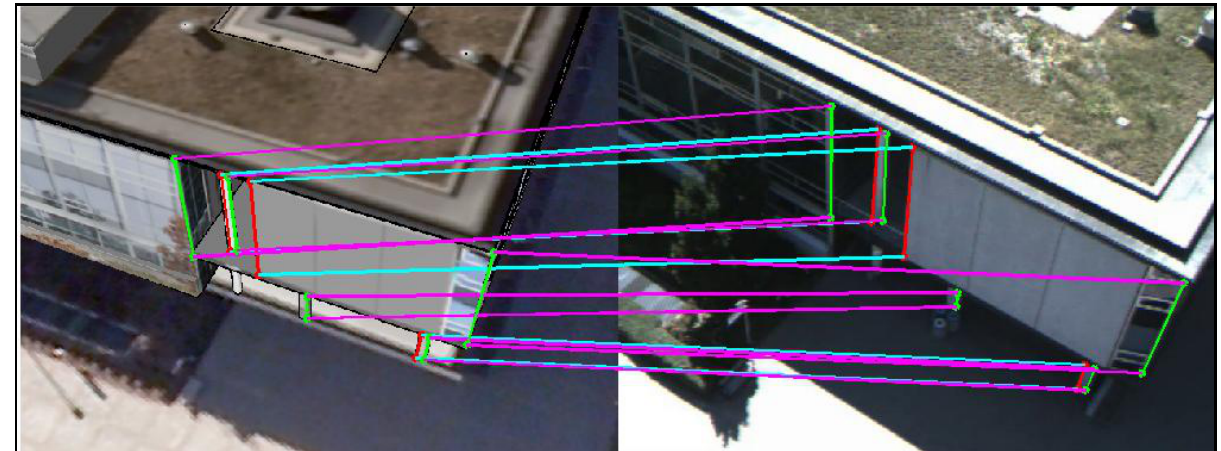
Figure 13. Corresponding Left (green) and Right (red) Vertical Line